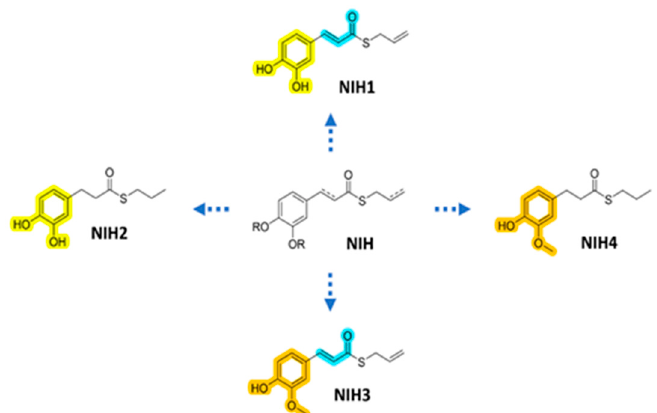
Figure 1. Molecular structures of NIH used in this study with different structural features highlighted: yellow for proelectrophilic catechol motif, blue for electrophilic α , β -unsatured carbonyl fragment and orange for curcumin-like o-methoxyphenol